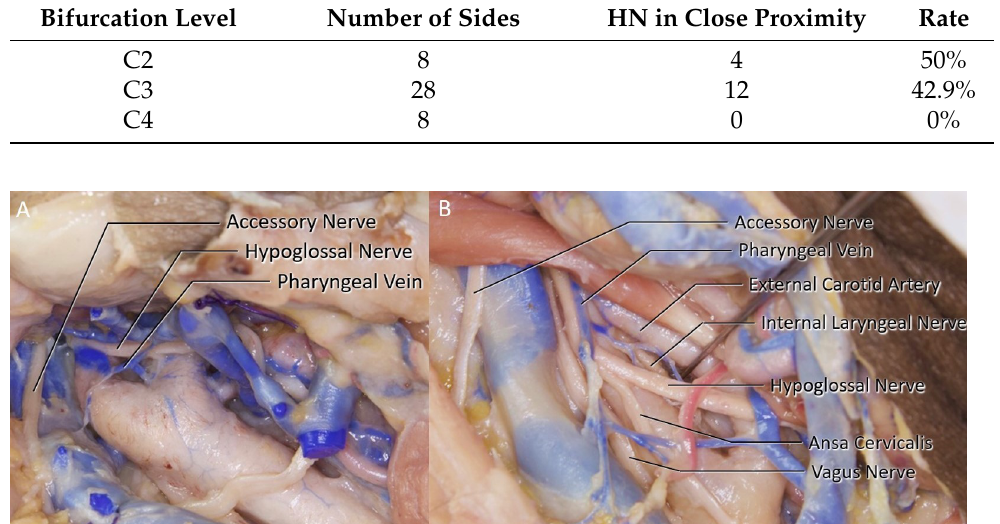
Figure 5. ( A ) Right side carotid bifurcation at the level of C2 vertebra. The hypoglossal nerve can be visualized but a mobilization may not be necessary. ( B ) The right-side hypoglossal and vagus nerve can be visualized as the internal carotid artery bifurcates at the level of the C2